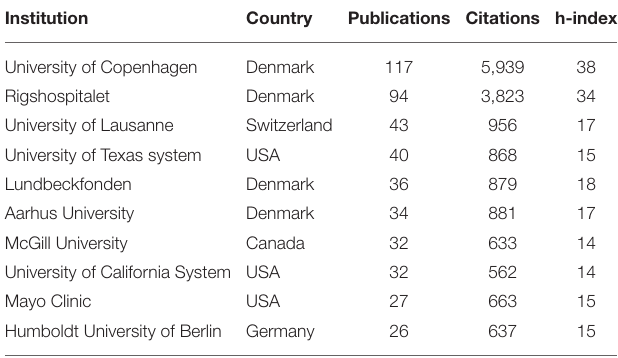
TABLE 4 | Top 10 institutions with the greatest number of publications.